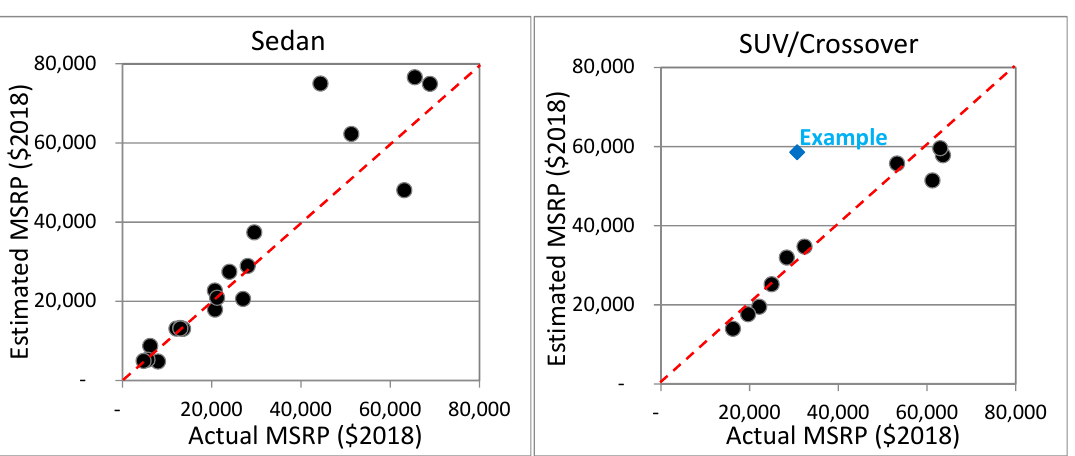
19 of 25 Figure 11. ( a ) Share of sedan models by vehicle size and by brand origin; ( b ) share of SUV models by vehicle size and by brand; ( c ) the relationship between MSRP and MPG by brand origin; and ( d ) relationship trend of MSRP and MPG in sedans ranging from $12,000 to $13,000 (bubble size indicates the sales). 4.2. Relationship Quantification Between Vehicle Price and Features 4.2.1. Vehicle Price Estimation and Validation To validate the reliability of the statistical mode which quantifies the relationships between vehicle features and vehicle prices based on the vehicle market data, this study randomly selects 20 different sedan models and 12 different SUV/crossover models from the best-selling vehicle models in the 2019 Chinese vehicle market. In sedans, it selects four vehicle models from each of five vehicle size types (minicompact, subcompact, compact, midsize, and large), and in SUVs/crossovers, it selects three vehicle models from each of four size classes (subcompact, compact, midsize, large). Figure 12 shows the projected MSRPs based on the statistical model discussed in Section 3.3. The projected and actual MSRPs of most vehicle models are close to one another, and the deviations for most vehicle models fall within a reasonable range. However, the projected and actual MSRPs of some vehicle models differ significantly. This does not necessarily mean the model works inefficiently. It might be because the listed MSRPs of the vehicle models deviate from the market average. For example, as shown in Figure 12, the blue point in the SUV/crossover segment stands for a large SUV/crossover model produced by a Chinese manufacturer with a short history in the auto industry. The actual